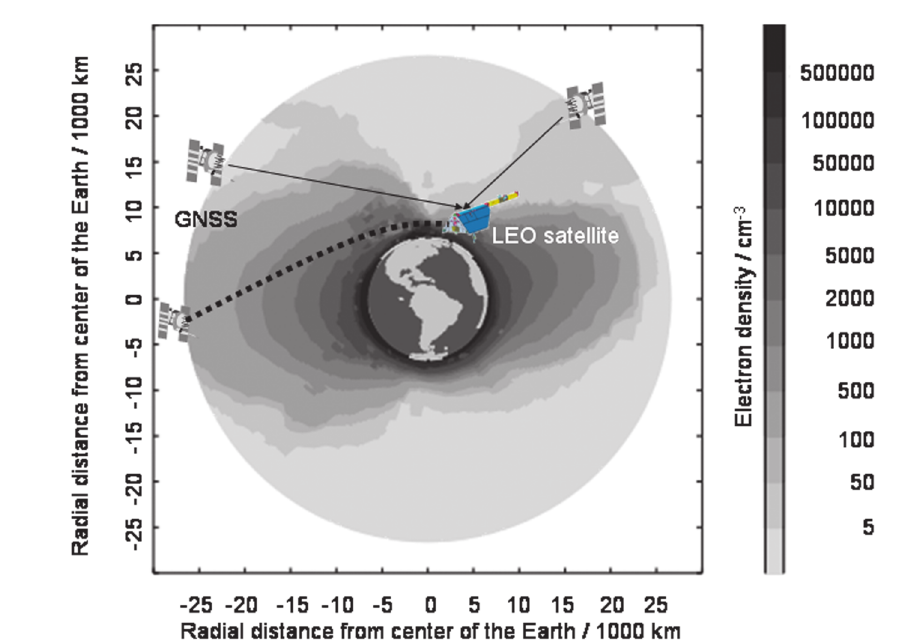
Fig. 3. Schematic view on GNSS based monitoring in SWACI: (1) – ground based GPS monitoring; (2) – radio occultation; (3) – topside reconstruction using GPS navigation